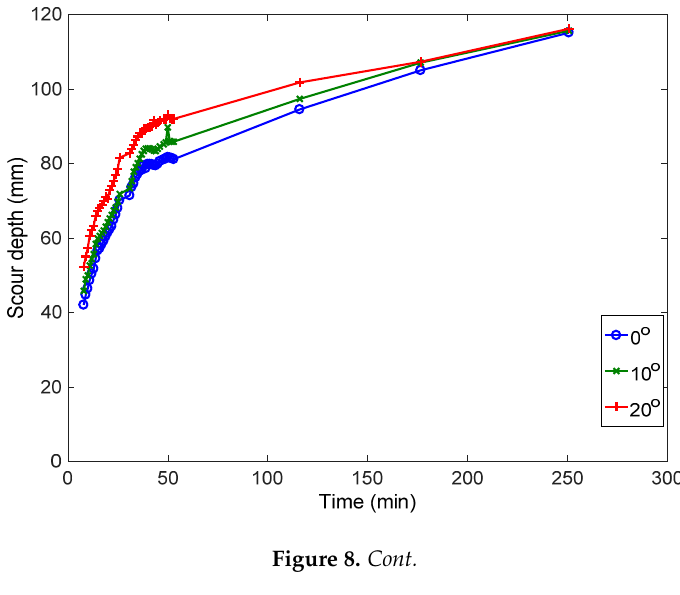
Figure 7. Examples of the piecewise curve fitting for the temporal functions of scour.